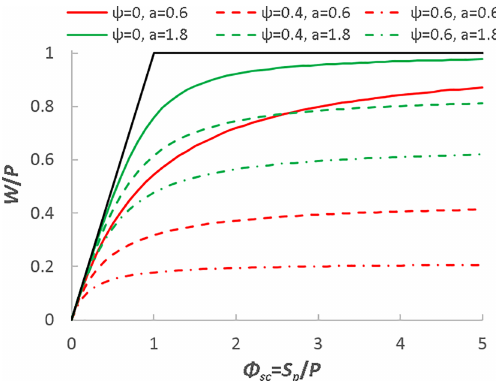
Figure 5. The effects of the degree of initial storage ( ψ = 0, 0.4, and 0.6) and shape parameter ( a = 0 . 6 and 1.8) on soil wetting in the modified SCS-CN method derived from the proposed distribution function for soil water storage